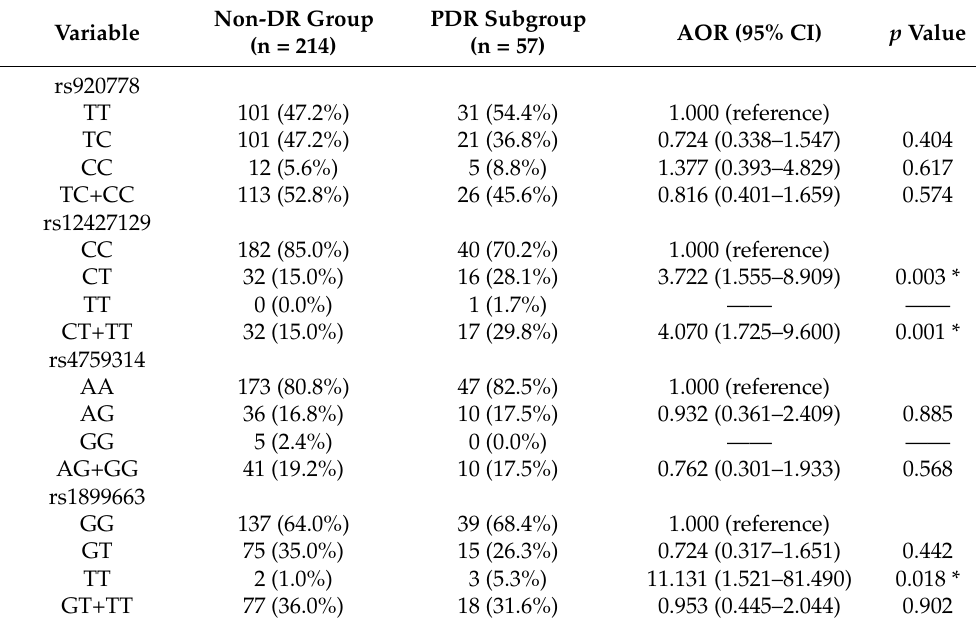
Table 5. Odds ratio and 95% confidence interval of proliferative diabetic retinopathy associated with HOTAIR genotypic frequencies in the female group.